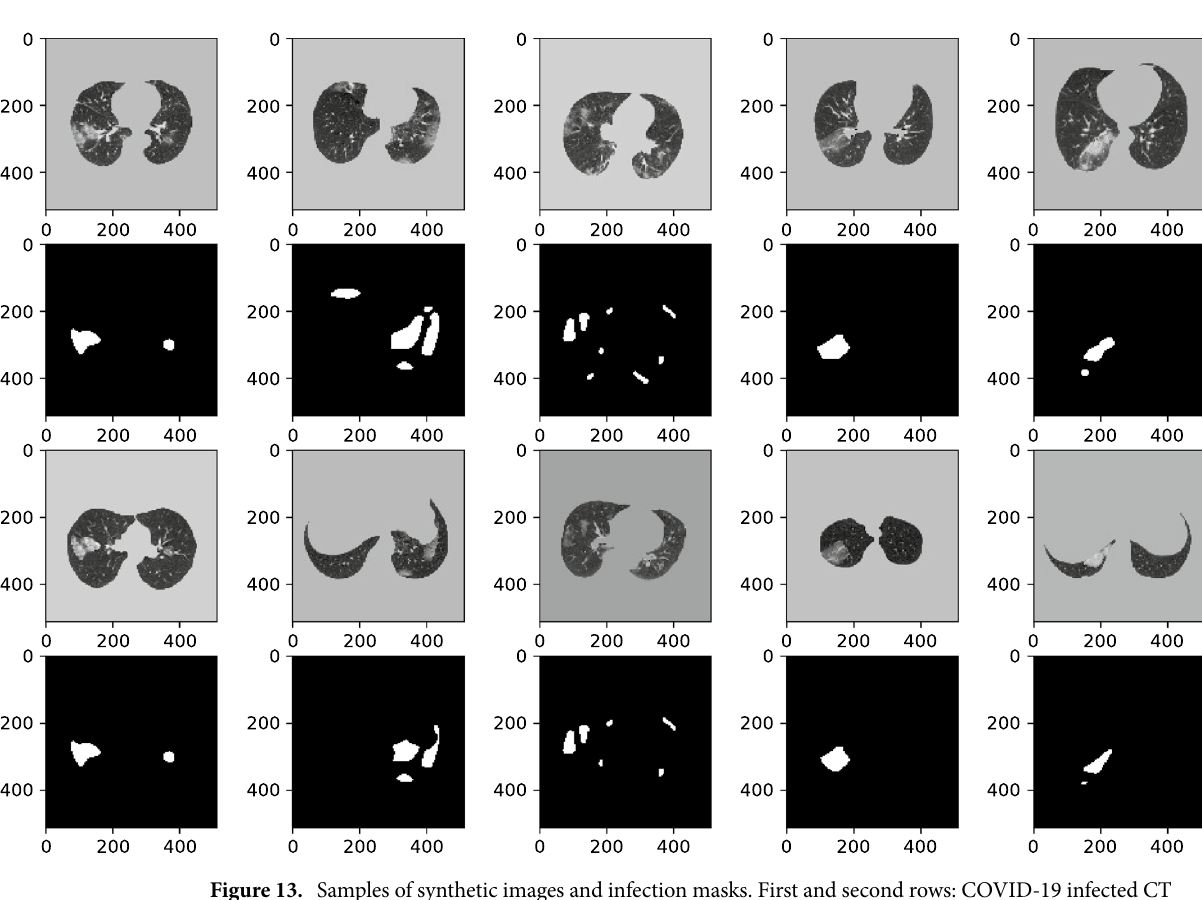
Figure 13. Samples of synthetic images and infection masks. First and second rows: COVID-19 infected CT images and their corresponding infection masks. Third and fourth rows: Synthetic images and the adjusted infection masks.